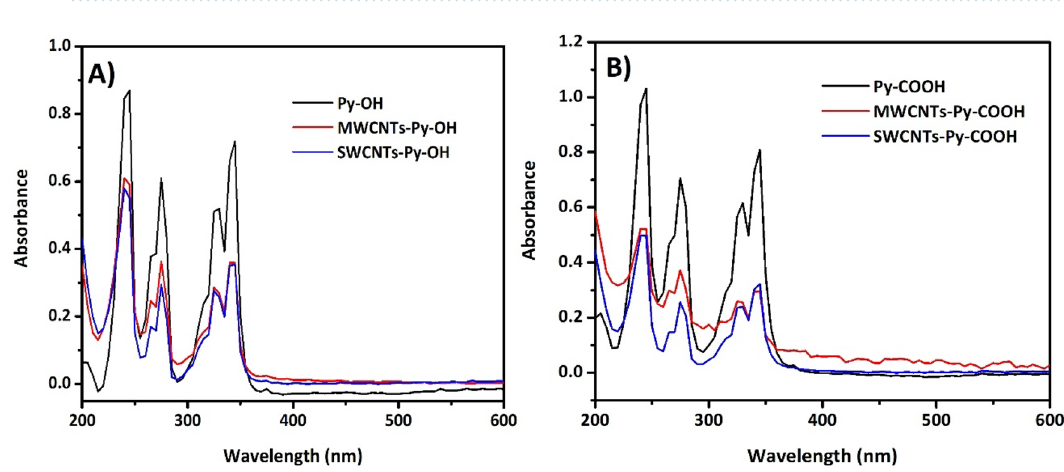
Figure 6. UV–Vis spectra of ( A ) Py-OH, MWCNTs-Py-OH, SWCNTs-Py-OH, and ( B ) Py-COOH, MWCNTs- Py-COOH,